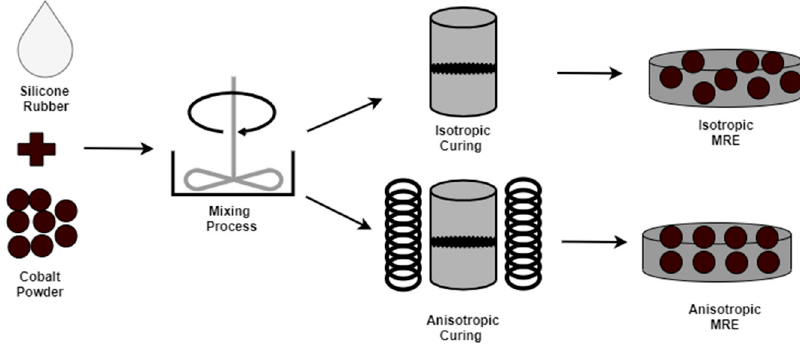
Table 1. Component of cobalt-based magnetorheological elastomer (MRE).